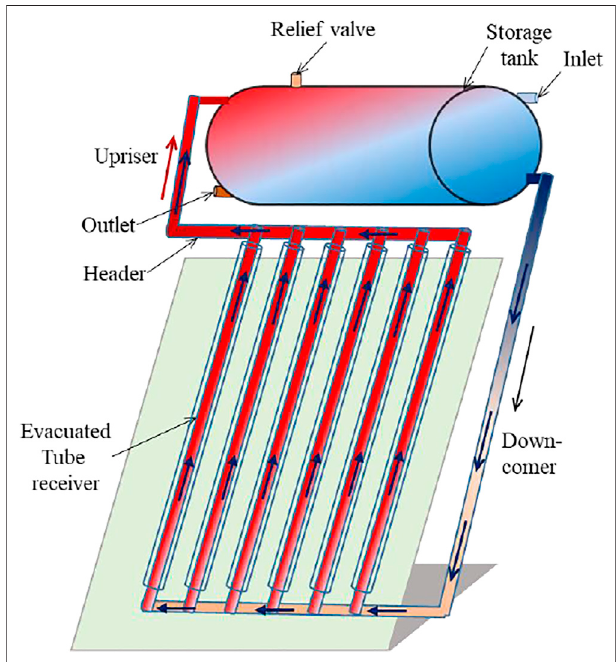
FIGURE 1 | Schematic diagram of a thermosyphon-based solar water heater.